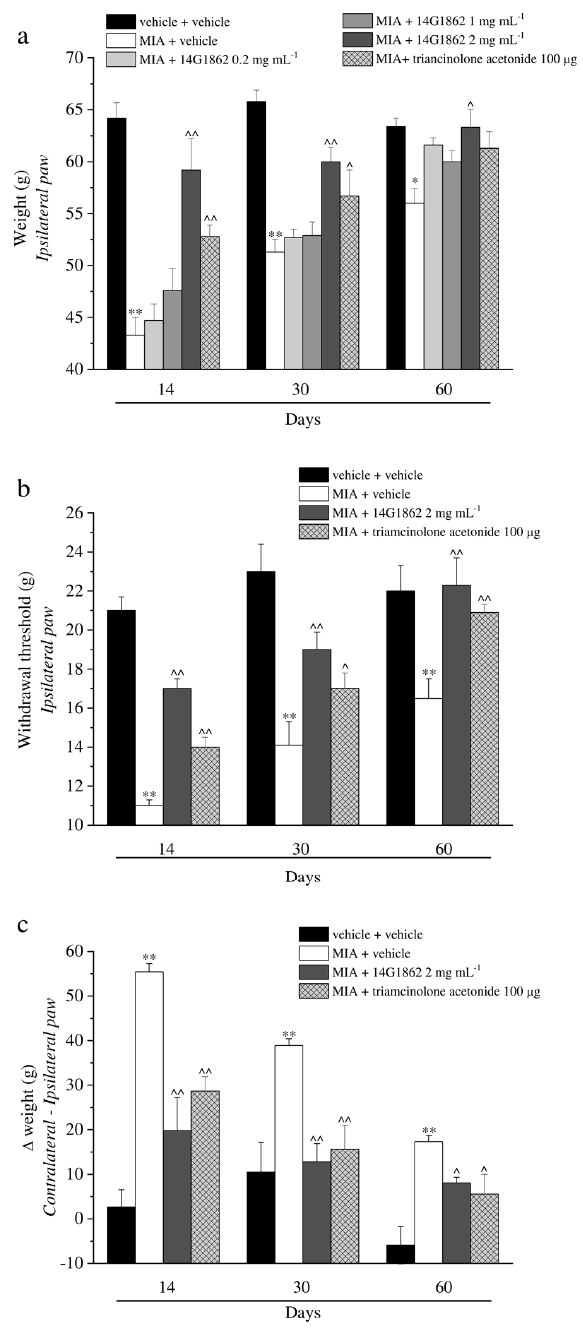
Figure 2. Articular pain, behavioural measurements related to hyperalgesia and allodynia. Monoarthritis was induced by MIA (2 mg/25 μ L) injection into the tibio-tarsal joint on day -7. Twenty μ L of 14G1862 (0.2–2 mg mL − 1 ) or triamcinolone acetonide 100 μ g were i.a. administered 7 days after MIA (day 1). Behavioural measurements were performed on days 14, 30 and 60 after osteoarthritis induction. The results obtained with the lower doses of 14G1862 were reported only in the Paw pressure test. ( a ) Effect of i.a. injection of 14G1862 in the rat, response to a noxious mechanical stimulus (Paw pressure test); ( b ) Effect of i.a. injection of 14G1862 in the rat, response to a non-noxious mechanical stimulus (Von Frey test); ( c ) Effect of i.a. injection of 14G1862 in the rat, measure of postural equilibrium related to pain (Incapacitance test). Each value represents the mean ± S.E.M. of 6 rats per group, performed in 2 different experimental sets. ** p < 0.01 vs. vehicle + vehicle; ^ p < 0.05 and ^^ p < 0.01 vs. MIA + vehicle.